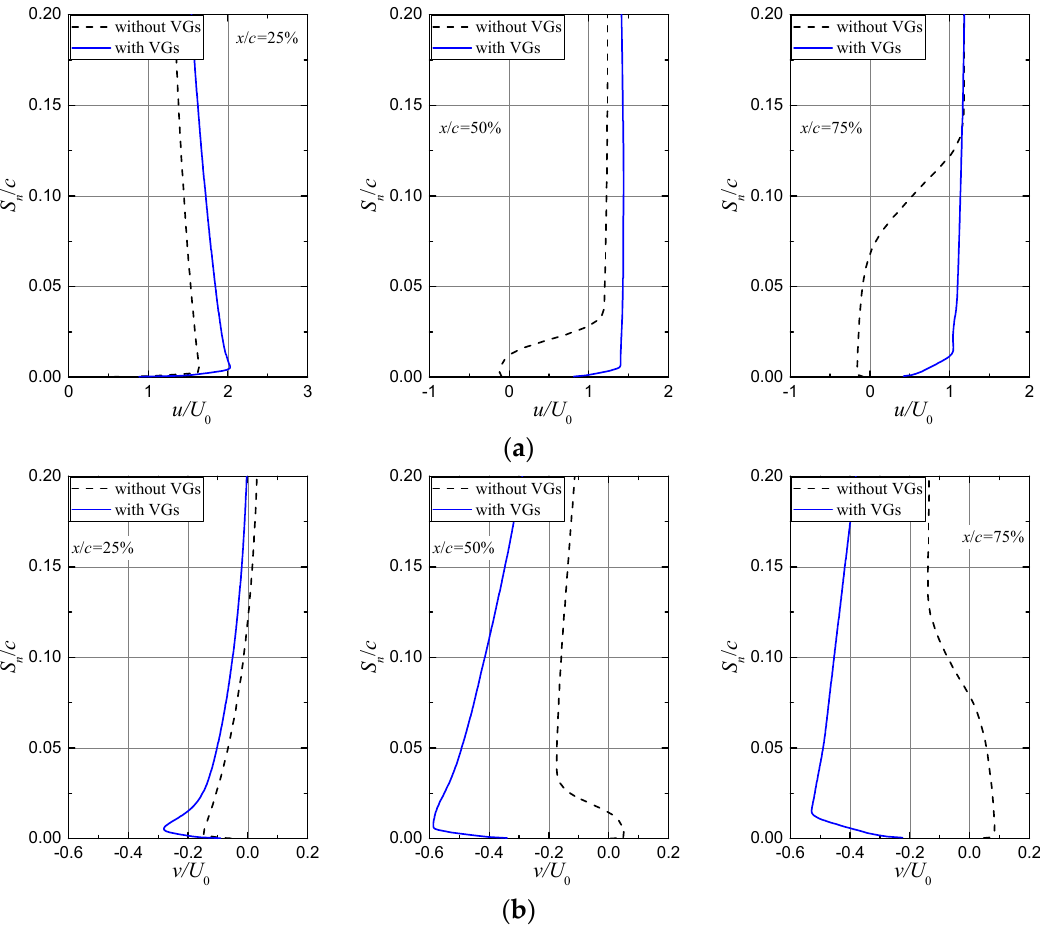
Figure 9. Streamwise and normal velocity profiles at 25% c (left), 50% c (middle), and 75% c (right) chordwise locations at α = 15 ° . S n denotes the normal distance away from the wall surface: ( a ) streamwise velocity profile; ( b ) normal velocity profile.